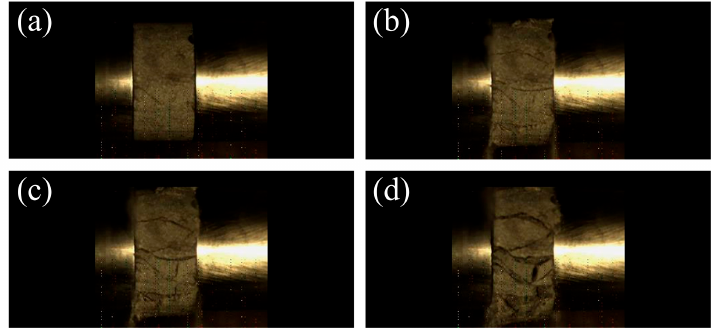
Figure 21. Failure process of a sandstone specimen at 209.3 s − 1 : ( a – d ) represent four moments of failure in chronological order.